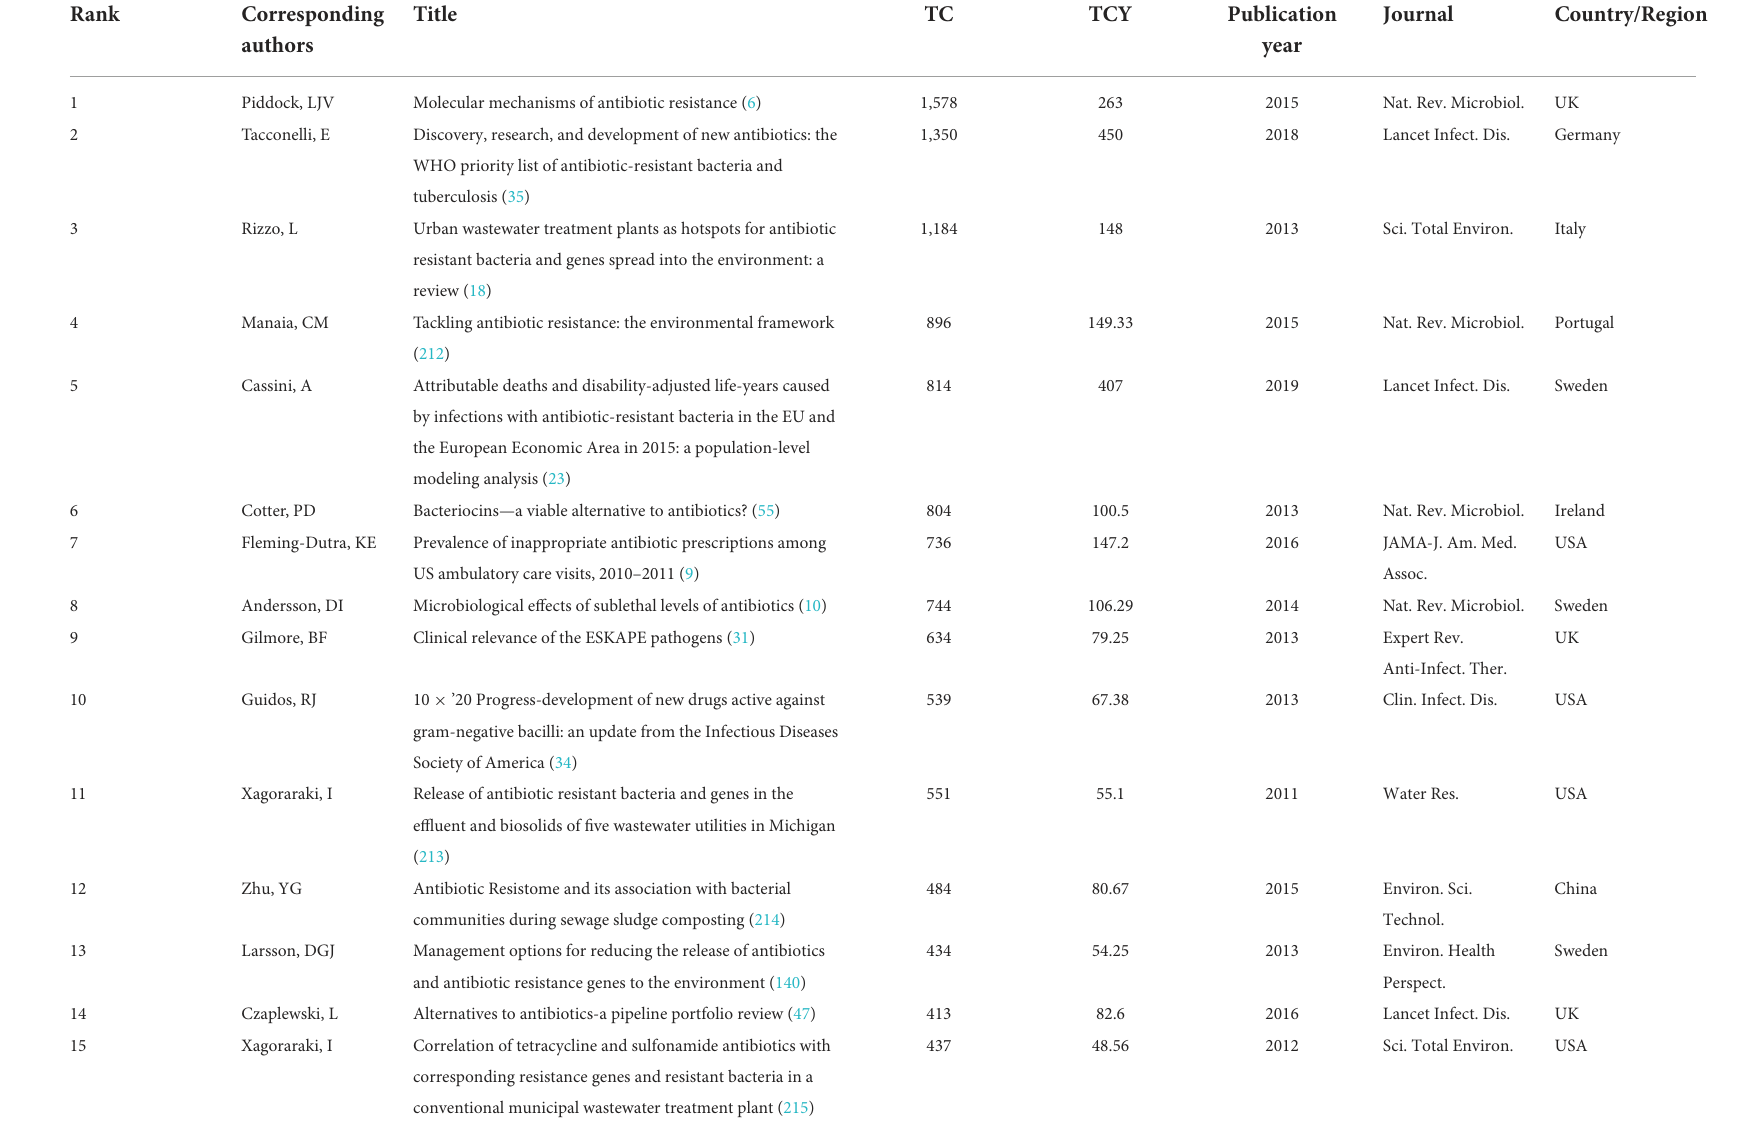
TABLE 6 The top 20 most cited publications of ESI in ARB research field during